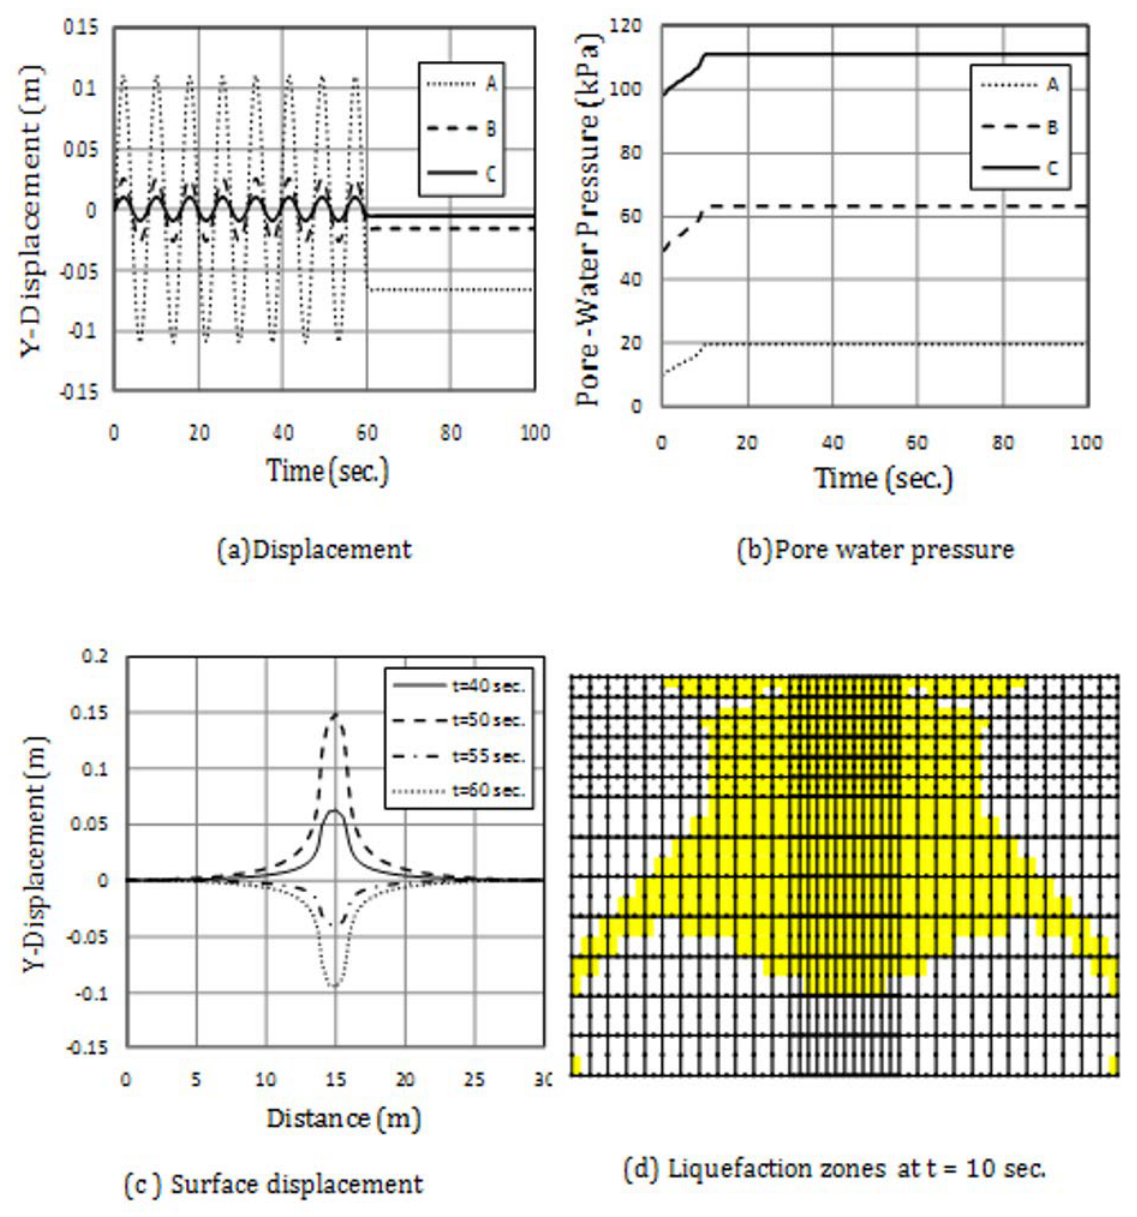
Figure 19. Dynamic response of the foundation to harmonic load, a